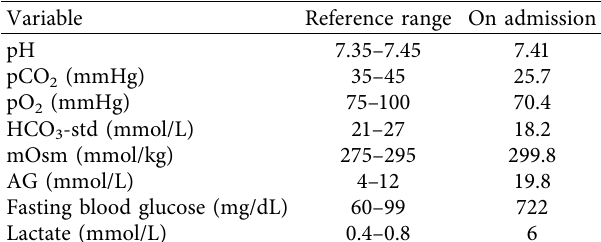
Table 2: Arterial blood gas